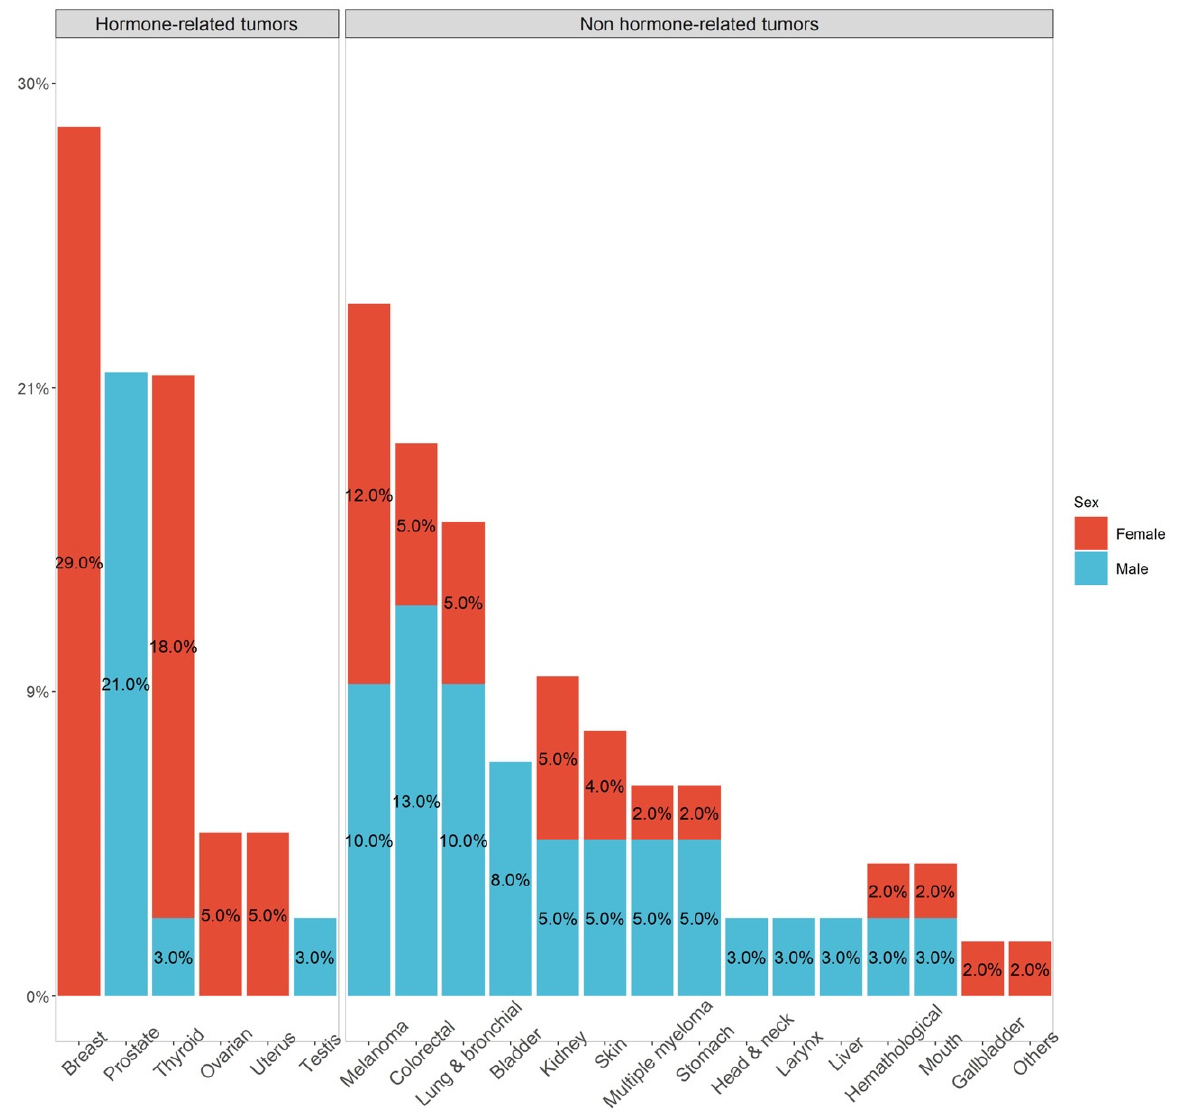
Figure 1. Frequency of second malignant tumor, according to gender (in red females, in blue males) divide into hormone-related and non-hormone-related tumors. Twenty-nine (30.5%) of second malignant tumors were discovered after the diagnosis of PPGLs. Comparing our series with the general population [17], the standardized inci- dence ratio (SIR) of the whole series was 9.59 (95% CI 5.46–15.71) in males, and 13.21 (95% CI 7.52–21.63) in females. The same figure was also observed in the group of subjects who